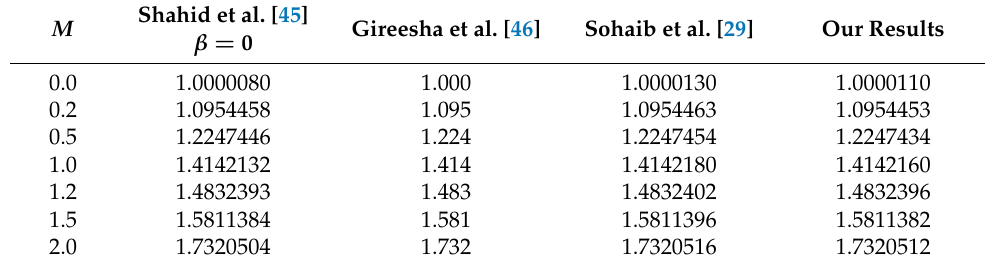
Table 1. Comparison of skin friction coefficient for various values of M .